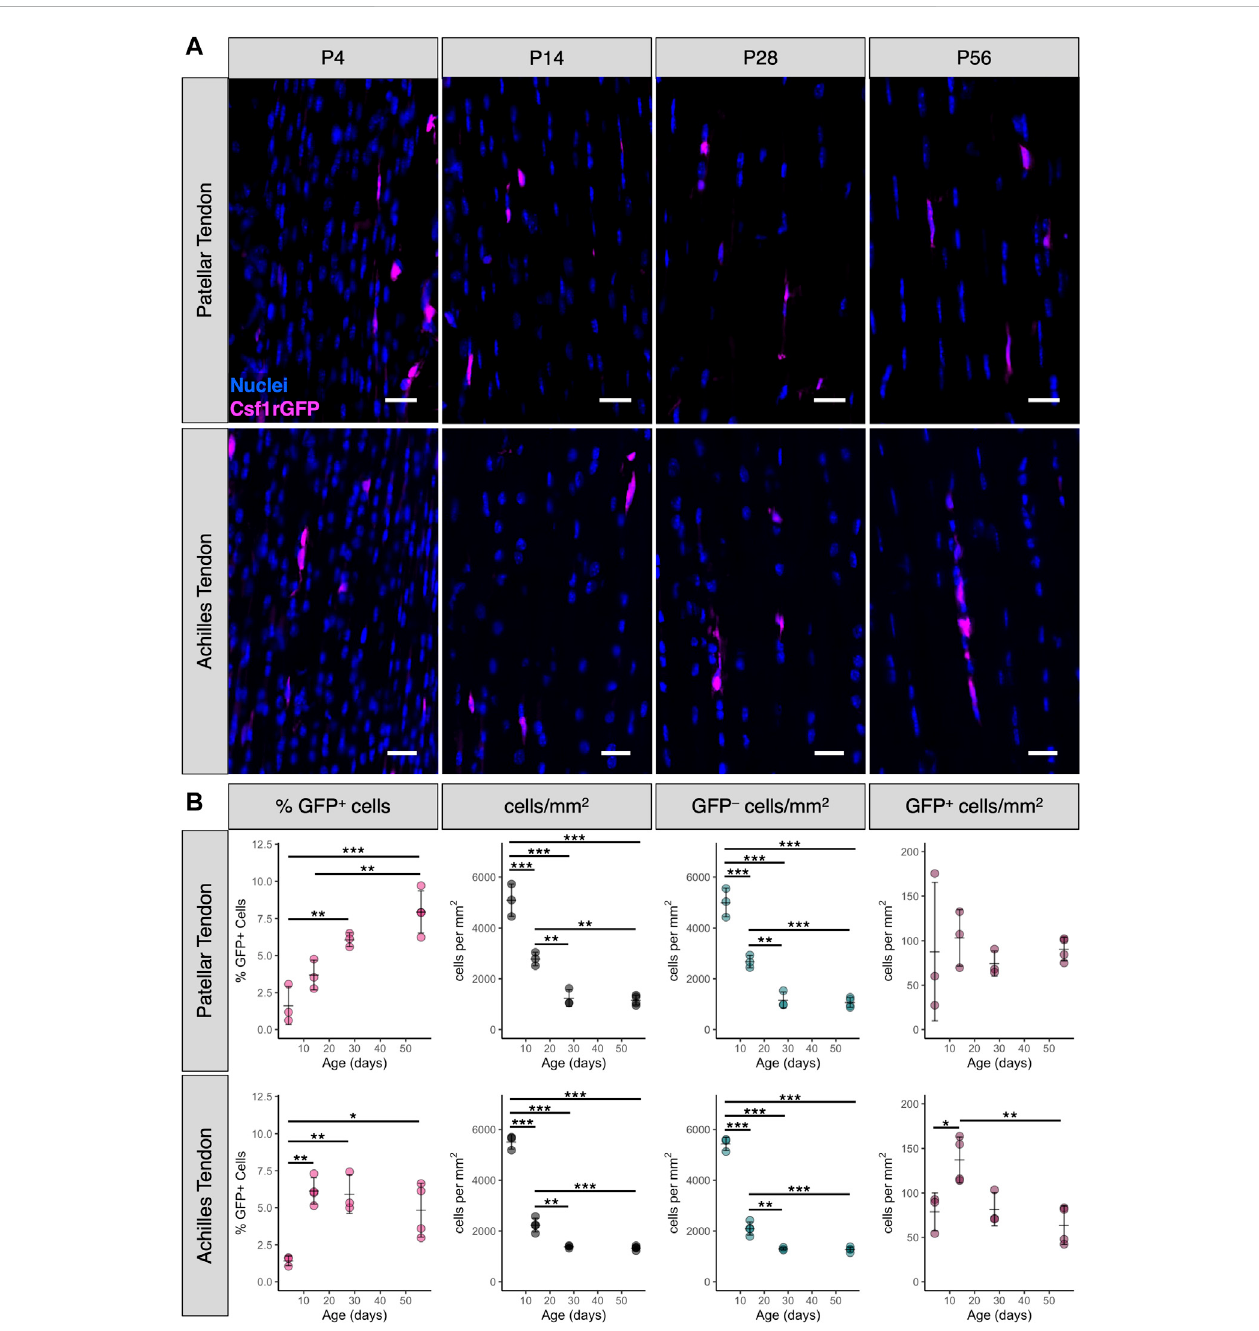
Figure S3). The spatial distribution of macrophages was uniform along the length of the patellar tendon midsubstance. In contrast, the density of macrophages in the Achilles tendon appeared to increase from the distal region near the calcaneus to the proximal region near the myotendinous junction (Supplementary Figure